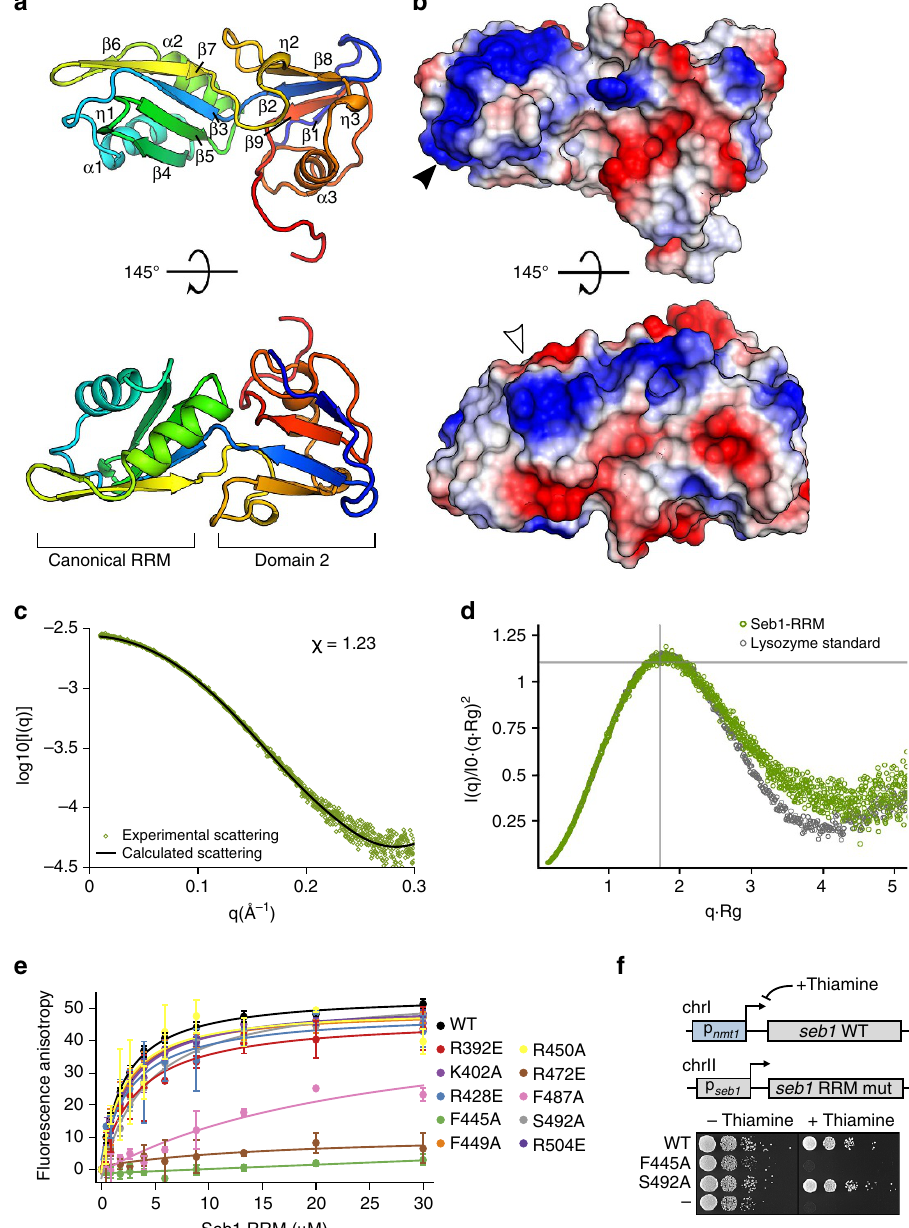
Figure 3 | The Seb1-RRM domain has an unusual structure and RNA binding is essential. ( a ) Crystal structure of the Seb1-RRM 388–540 domain is shown as a cartoon representation, coloured in blue to red from the N- to the C-terminus. The position of the canonical RRM and the additional RRM-like domain is indicated below the structure. The two domains are interwoven and cross over between b 2 and b 3. ( b ) Electrostatic surface of the Seb1-RRM 388–540 shown in the same orientations as in a . Positively charged areas are coloured in blue and negatively charged areas in red. Arrows indicate a contiguous positively charged region tentatively assigned to interaction with the RNA phosphate backbone. ( c ) Plot showing a solution SAXS curve of the Seb1-RRM 388–540 (green). To compare the solution and crystallographic conformations of the Seb1-RRM 388–540 , a scattering profile was computed from the X-ray structure (black) and fitted to the solution scattering data. The quality of the fit as expressed as w is indicated. ( d ) Flexibility analysis of the Seb1-RRM 388–540 (green) and a lysozyme standard (grey, BioisisID: LYSOZP) via dimensionless Kratky plot is shown. The intersection of the lines p indicates the Guinier–Kratky point ( ffiffiffi 3 , 1.104), the peak position of an ideal globular and rigid protein. Rigid proteins show a characteristic parabolic shape with a peak at the indicated position (as is the case here), while unfolded proteins would plateau with increasing q -values. ( e ) Analysis of Seb1-SUMO-RRM 388–540 binding to FAM-tagged AUUAGUAAAA RNA by FA. Error bars indicate standard deviation of three technical replicates. ( f ) Spot test showing the effect of the indicated Seb1-RRM point mutations on cell